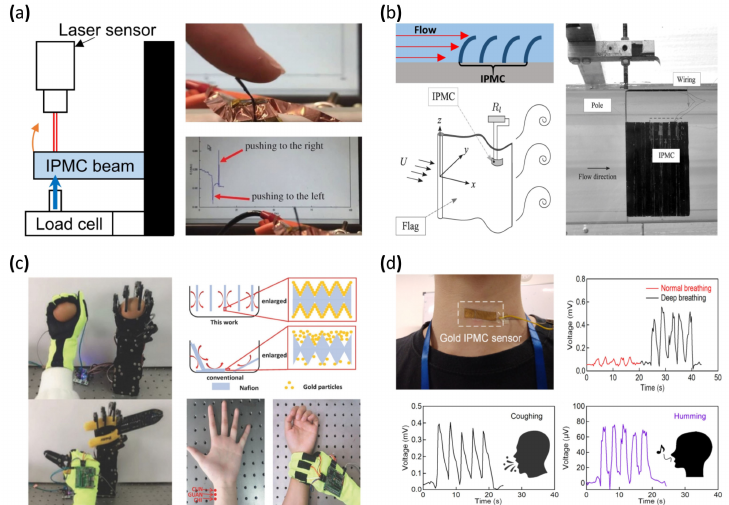
Figure 10. Demonstration of IPMC based sensor. ( a ) Experiment setup of an IPMC bending sensor (left) and the corresponding signal response. Adapted from Wang et al. [157] with permission from The Royal Society, Copyright (2016). ( b ) Demonstration of IPMC fluid flow sensor/energy harvester. Adapted from Giacomello et al. [158] with permission from AIP Publishing, Copyright (2011). ( c ) Demonstration of a fluid bed-like reactor (right) and photograph of blood diagnosis and robot arm control. Adapted from Ming et al. [103] with permission from Wiley, Copyright (2018). ( d ) Photograph of an IPMC throat sensor and corresponding voltage signal graphs. Adapted from Lee et al. [97] with permission from MDPI, Copyright